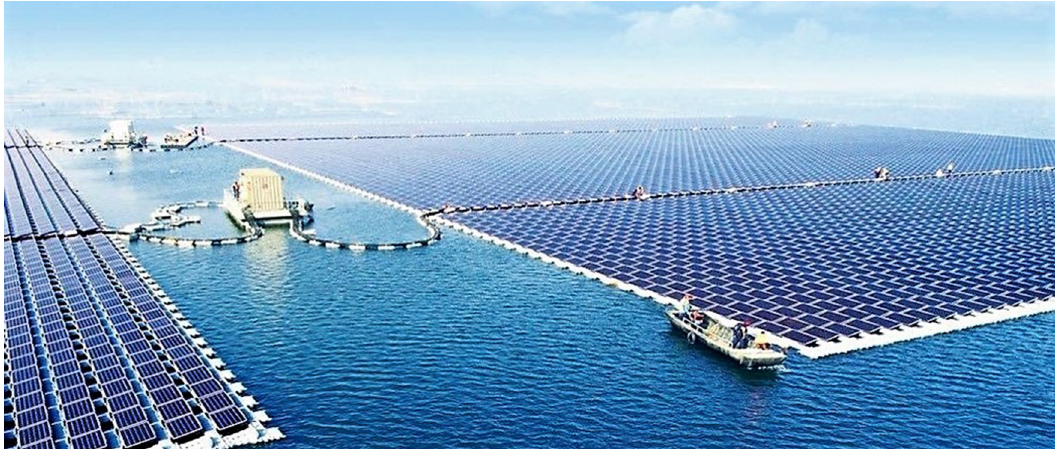
Fig. 18. The 40 MW fl oating solar power plant at Huainan, China, is the world ’ s largest. Enough to power a small town built June 2017 [27].